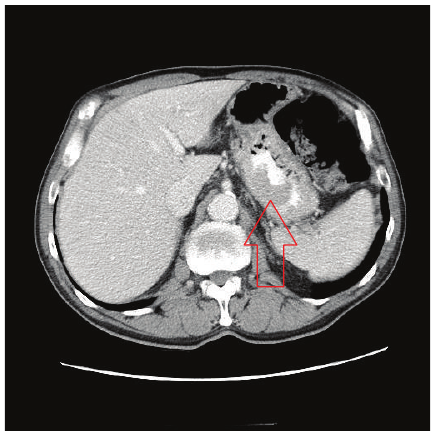
Figure 2: Computerized axial tomography scan with IV and PO contrast showing a mass in the gastric fundus (red